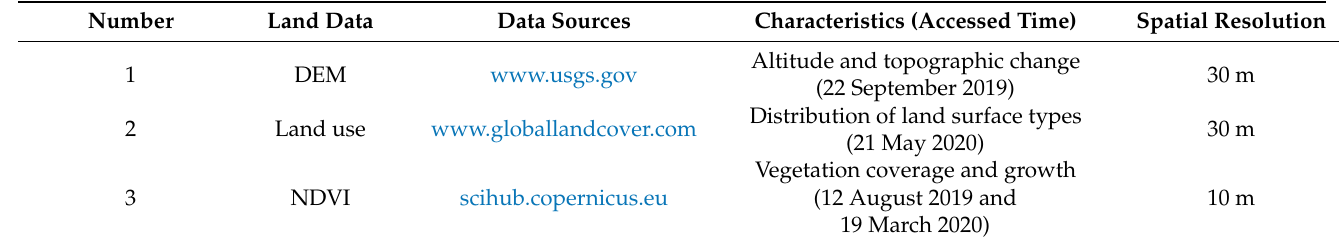
Table 1. Land surface data in the regional spatial distribution. DEM, digital elevation model; NDVI, normalized difference vegetation